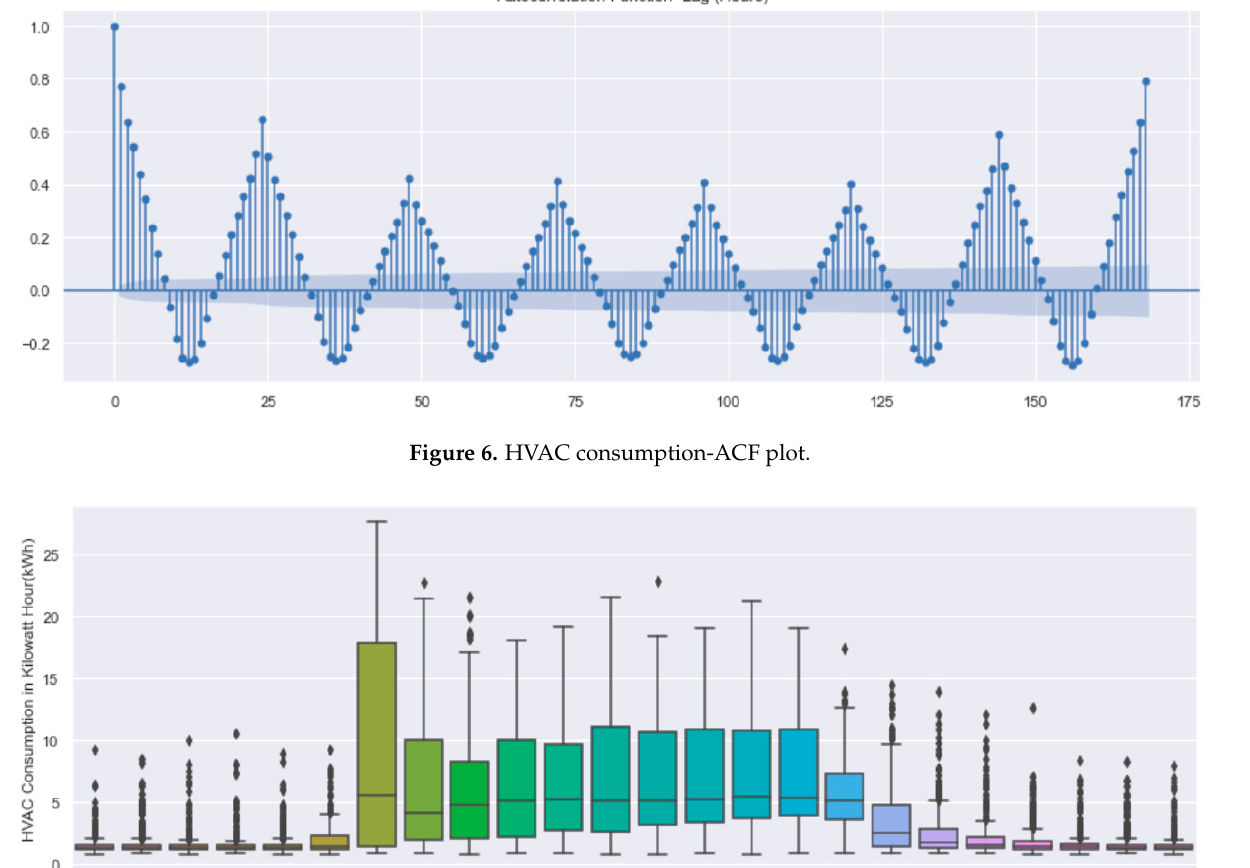
Figure 6. HVAC consumption-ACF plot .